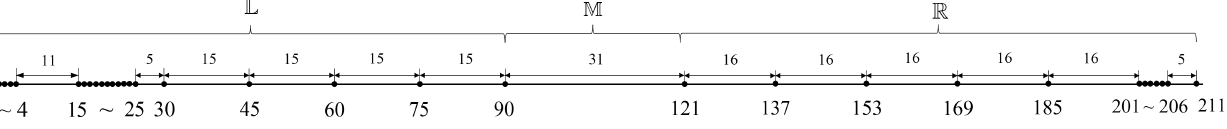
Figure 5. An example of TS2-ENA with N = 31, M = 1, R =